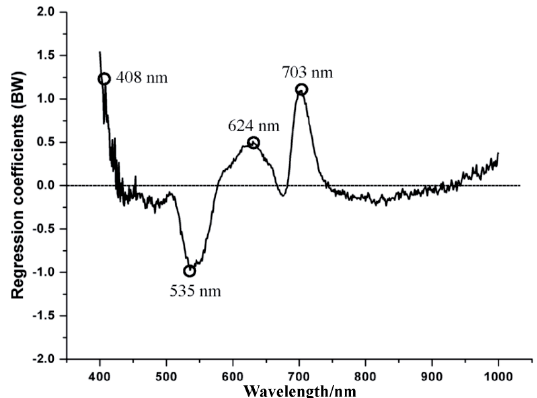
Figure 5. Effective wavelengths selected by regression coefficients.